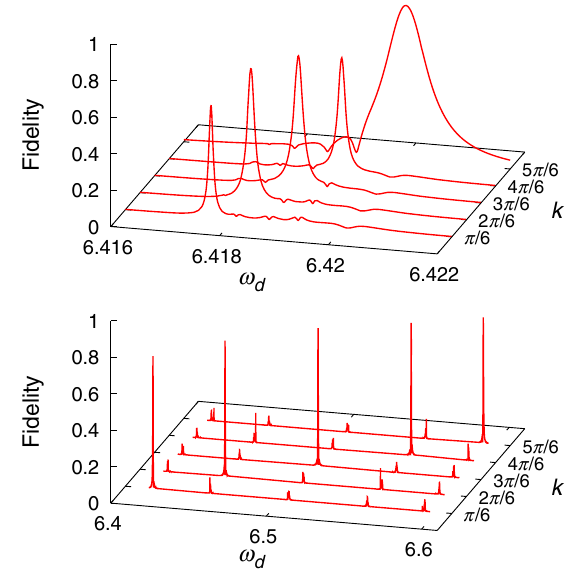
FIG. 4. Fidelities to all the possible j k i states versus drive frequency ω for open boundary conditions. (Top panel) Only d the first of the N ¼ 5 cavities is driven; the energy difference between driving to two neighboring j k i states is controlled by Δ ~ E ∼ 2 π J ð g= Δ Þ 2 =N . (Bottom panel) However, when all cavities are driven equally, the energy differences are controlled by Δ ω ∼ 2 π J=N , allowing a much better control over stabilizing the desired target state. Please note the widely different scales for the frequency ranges shown in the two plots. ϵ d ¼ 0 . 3 , ω